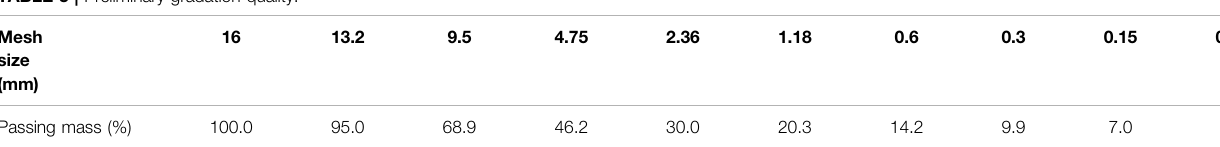
TABLE 3 | Preliminary gradation quality.